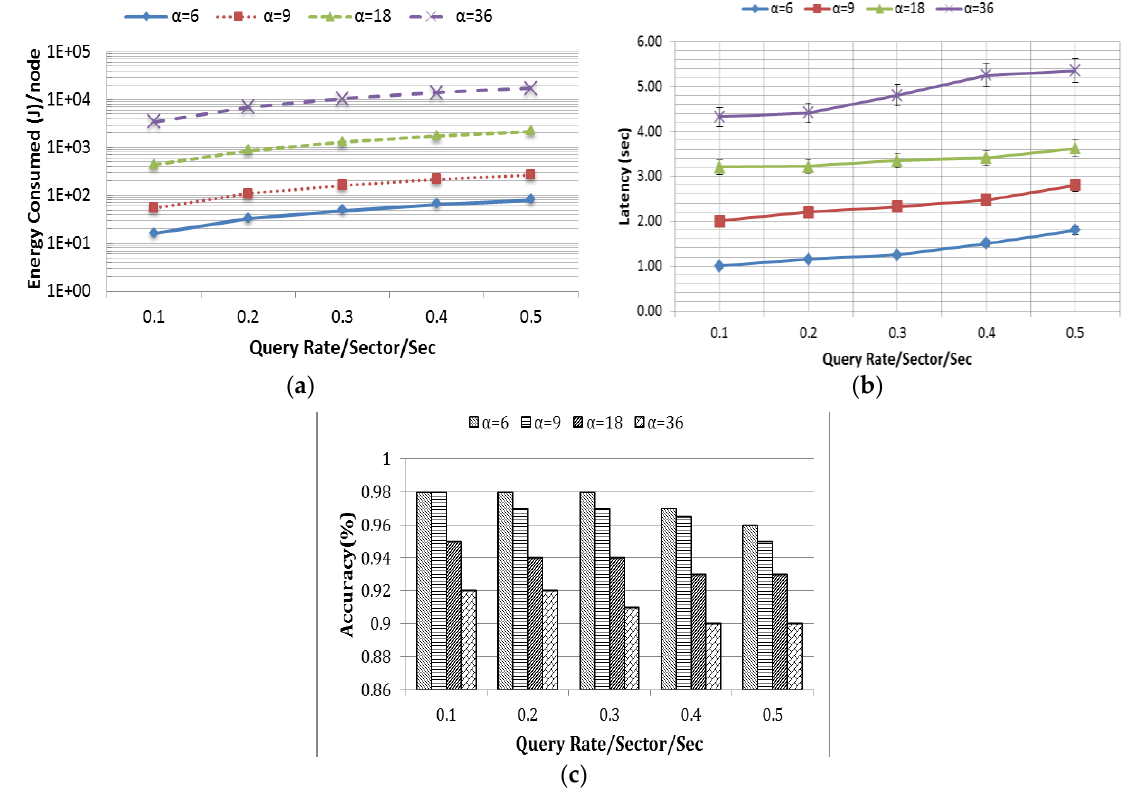
Figure 13. ( a ) Energy consumption; ( b ) latency; and ( c ) accuracy.